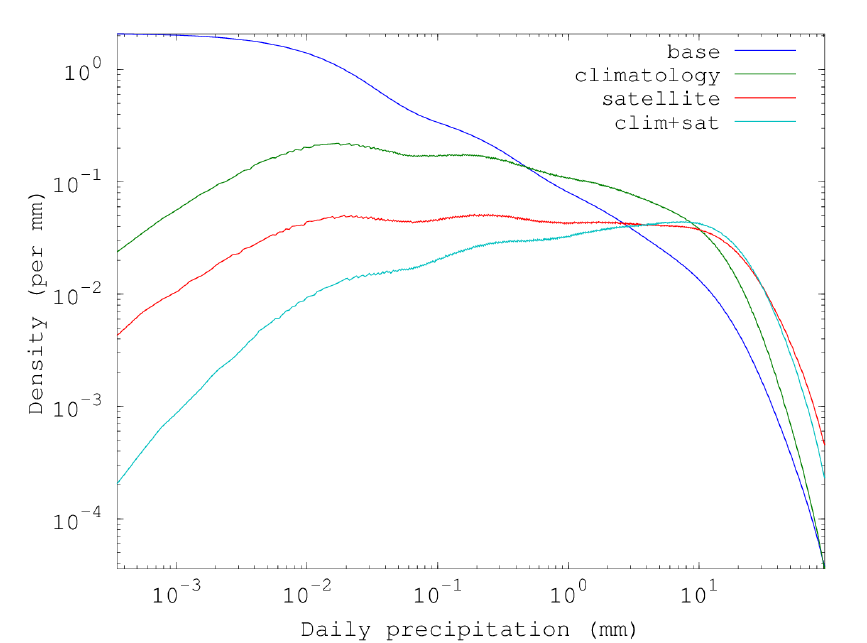
Figure 6. Example probability density functions for daily precipitation amount at the grid point containing Kathmandu, Nepal (27.7 ◦ N, 85.3 ◦ E) for a heavy-rainfall monsoon day (2 September 2013): background PDF, climatology PDF taking into account location and season, and probabilities that incorporate data from the satellite precipitation product